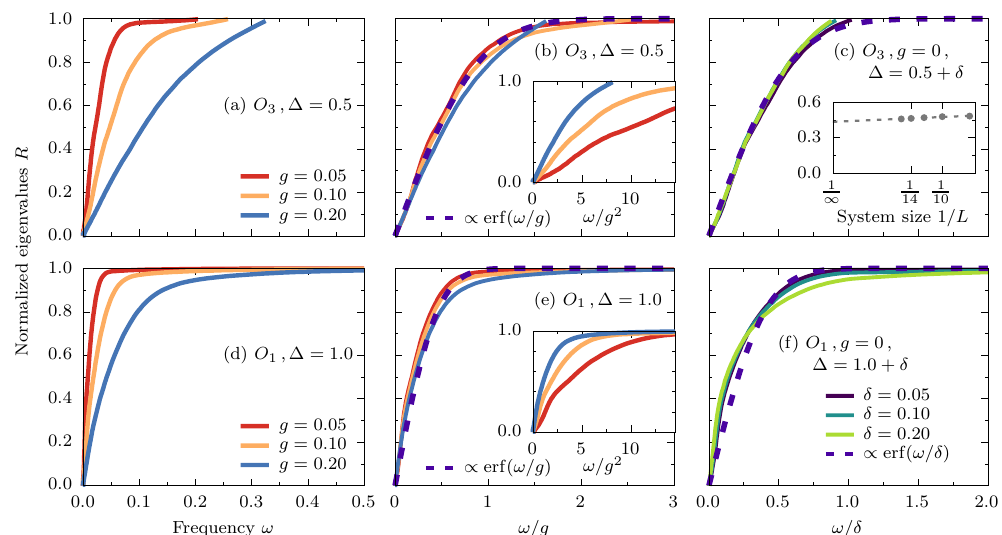
Figure 6: Cumulative spectral functions R α ( ω ) , Eq. (14), as calculated for L = 16 system. We show the results for (a) O with ∆ = 1 / 2 and (d) for O with ∆ = 1. 3 1 Panels (b) and (e) show respectively the same data but with rescaled frequency ω/ g (main panels) and ω/ g 2 (insets). Panels (c) and (f) show the results for integrable system ( g = 0) but for shifted anisotropy parameters ∆ = 0.5 + δ and ∆ = 1 + δ , respectively. Dashed curves show fittings with the error function. Inset in (c) shows ( t → ∞ ) for ∆ = 0.5 and g = finite-size scaling of the stiffness C 3